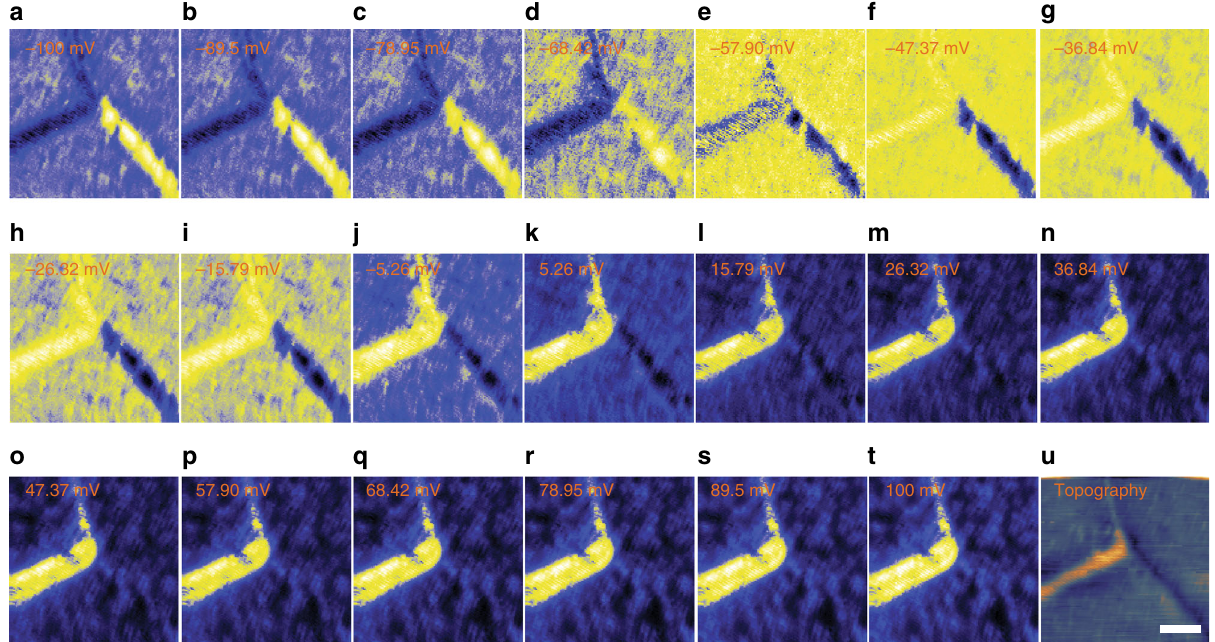
Fig. 6 (double columns) Spatial variation of local density of state near the junction at 77 K. a – t A set of differential conductance maps obtained near a junction of three domains and DWs. All of spectra are normalized to the same tunneling resistance with − 50 mV and 100 pA. Differential conductance spectra are obtained by demodulated lock-in signal using 10 mV of oscillation at 20 different biases from − 100 to 100 mV. Twenty lock-in measurements are interlaced in between each line-scan of the topography shown in u to minimize the effect of thermal drift. There appear two different characteristics from the DWs. Two DWs on the upper left corner show depressed local density of state at energies below − 50 mV, and start to show enhanced conductance above − 50 mV. On the contrary, the DW in the right bottom corner shows the opposite feature, i.e., enhanced below − 50 mV and suppressed above − 50 mV. u , STM topography of the same area with the 40 × 40 nm 2 image size. Scale bar: 10